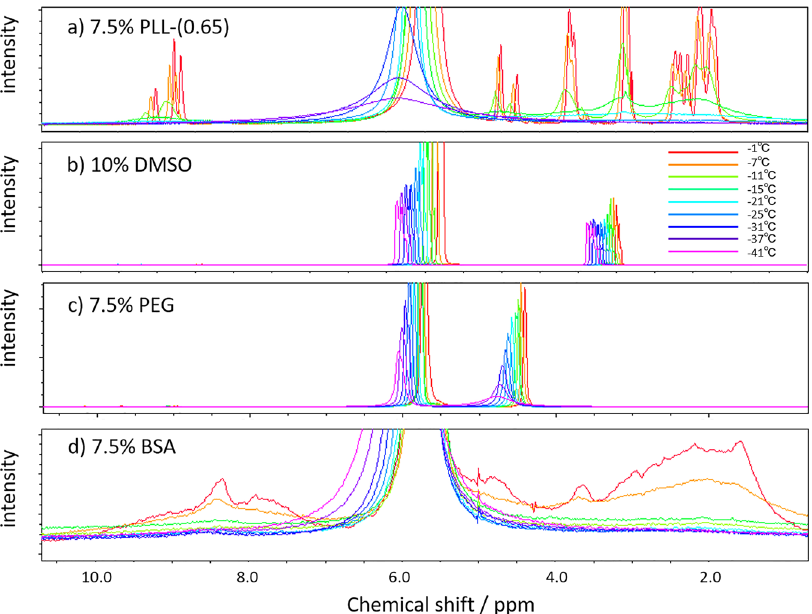
Fig. 6 Investigating the behavior of the 1 H NMR signals of various solutes over a range of temperatures. a – d Solid-state 1 H NMR spectra of a 7.5% PLL- (0.65), b 10% DMSO, c 7.5% PEG, and d 7.5%